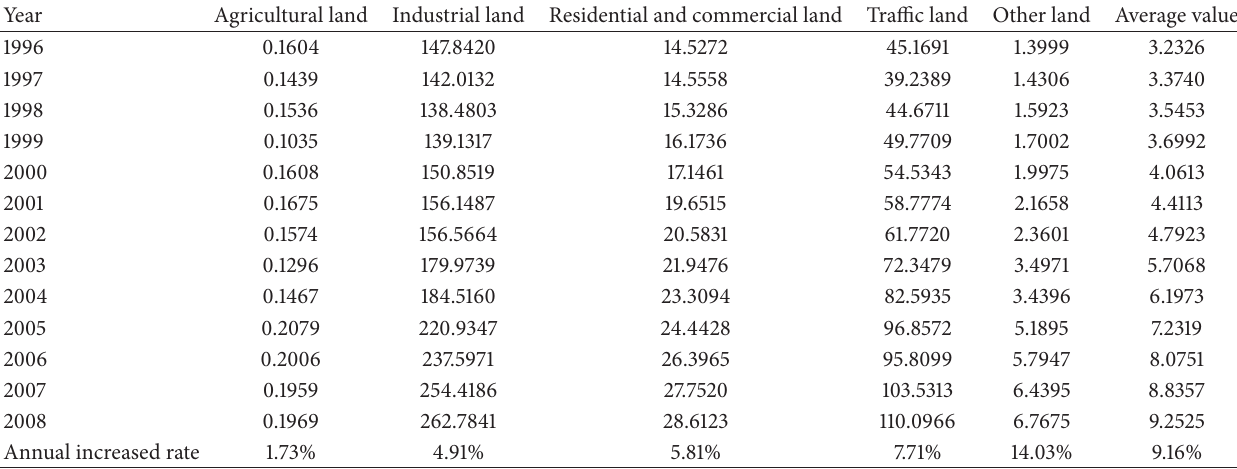
Table 6: Carbon intensities in different land use types from 1996 to 2008 (t/hm 2 ).